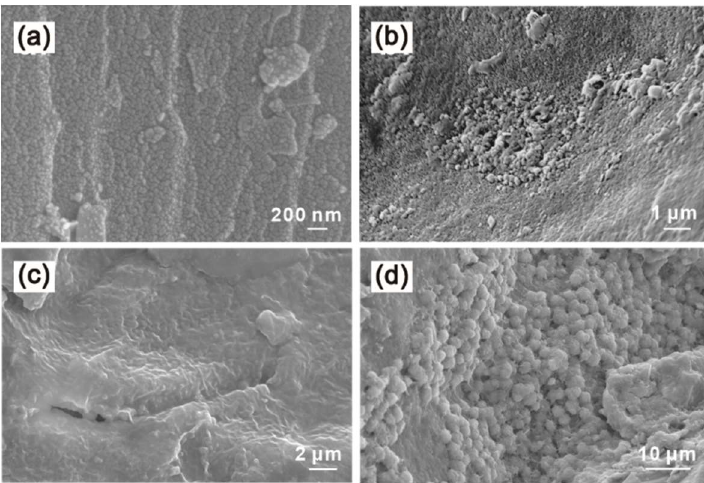
Figure 11. Layers and silica aggregates observed by SEM. ( a ) Opal-01 shows a layered structure; ( b ) Silica aggregates of various shapes and agglomerates on Opal-08 (diameters 130–500 nm); ( c ) Blurred boundary of Opal-09; ( d ) Close-packed small spheres on the surrounding rock of Opal-09 with diameters of 2.2–3.8 μm (2200–3800 nm).